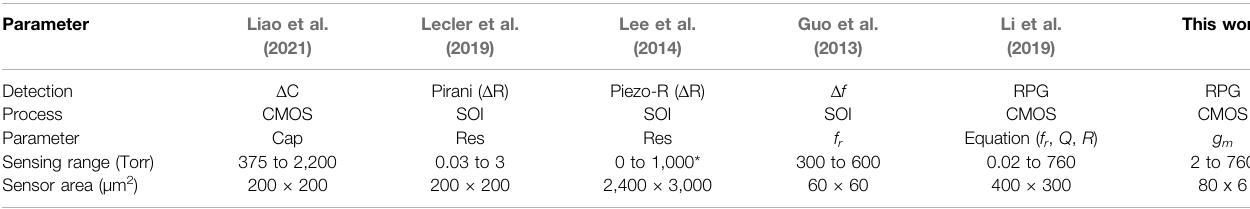
TABLE 4 | Performance comparison with prior works for pressure sensing.